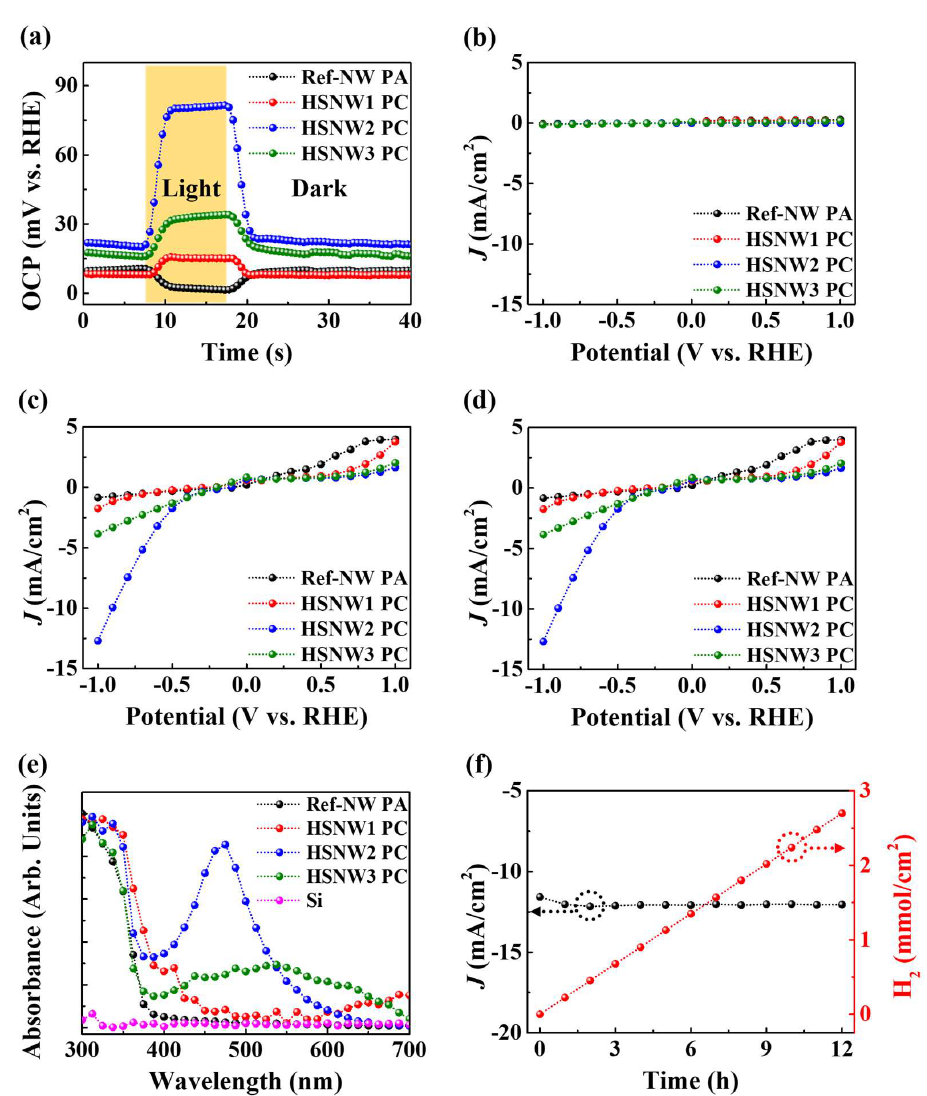
Figure 3. ( a ) Time-dependence of the OCP curves of the Ref-NW PA and HSNW1, HSNW2, and HSNW3 PCs in 0.5-M H 2 SO 4 electrolyte. J – V characteristic curves of the Ref-NW PA and HSNW1, HSNW2, and HSNW3 PCs under ( b ) dark and ( c ) illumination condition. ( d ) ABPEs and ( e ) absorb- ance of the Ref-NW PA and HSNW1, HSNW2, and HSNW3 PCs. ( f ) Time-dependent PEC-WS of the HSNW2 PC for 12 h at a potential of −1 V versus RHE under illumination condition.